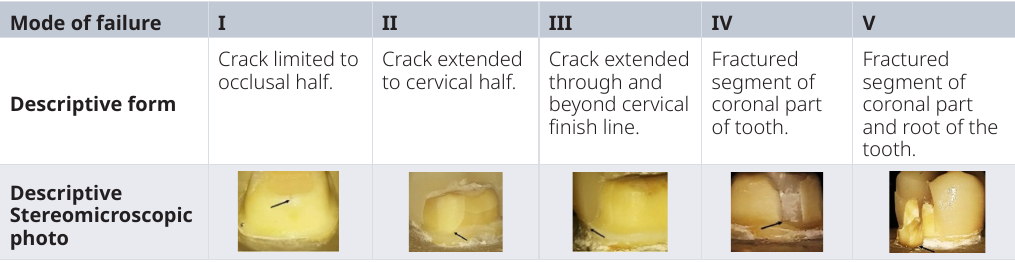
Table 5. Classification of the modes of failure. Restorable remaining tooth structure: modes I, II and IV; non-restorable remaining tooth structure: modes III and V.